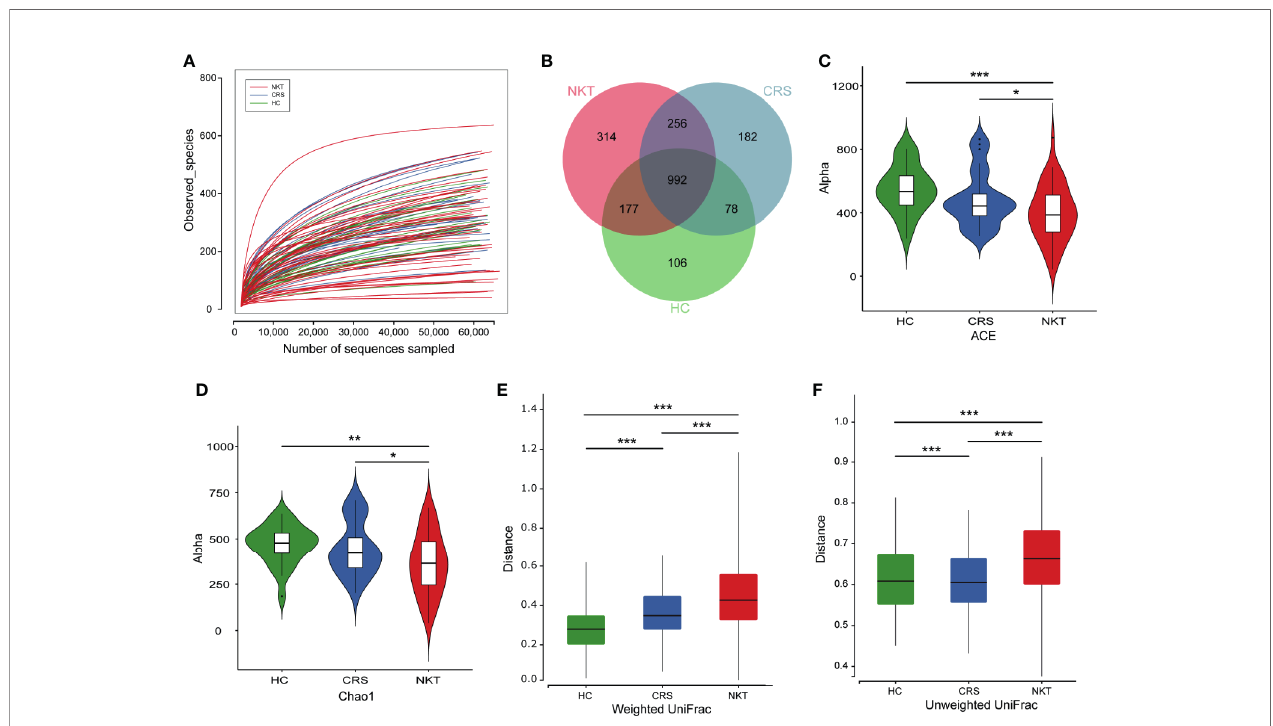
FIGURE 1 | Biodiversity of the nasal microbiota in the indicated groups. (A) Rarefaction curves of samples in the NKT (n = 46), CRS (n = 25) and HC groups (n = 24). (B) A Venn diagram displaying the overlap of OTUs among groups. Comparison of the microbial alpha diversity among groups using Student ’ s t test. (C) For the ACE index, P = 0.0481, NKT vs CRS; P < 0.001, NKT vs HC; (D) for the Chao1 index, P = 0.0353, NKT vs CRS; P = 0.0023, NKT vs HC. For beta diversity as measured by (E) the weighted UniFrac, P = 4.42e-18, NKT vs CRS; P =8.24e-47, NKT vs HC; P = 7.67e-11 CRS vs HC. (F) For the unweighted UniFrac index, P = 1.81e-28, NKT vs CRS; P = 1.49e-23, NKT vs HC; P = 1.05e-6 CRS vs HC. NKT, natural killer/T cell lymphoma; CRS, chronic rhinosinusitis; HC, healthy control; OTUs, operational taxonomy units; * P < 0.05, ** P < 0.01, *** P <